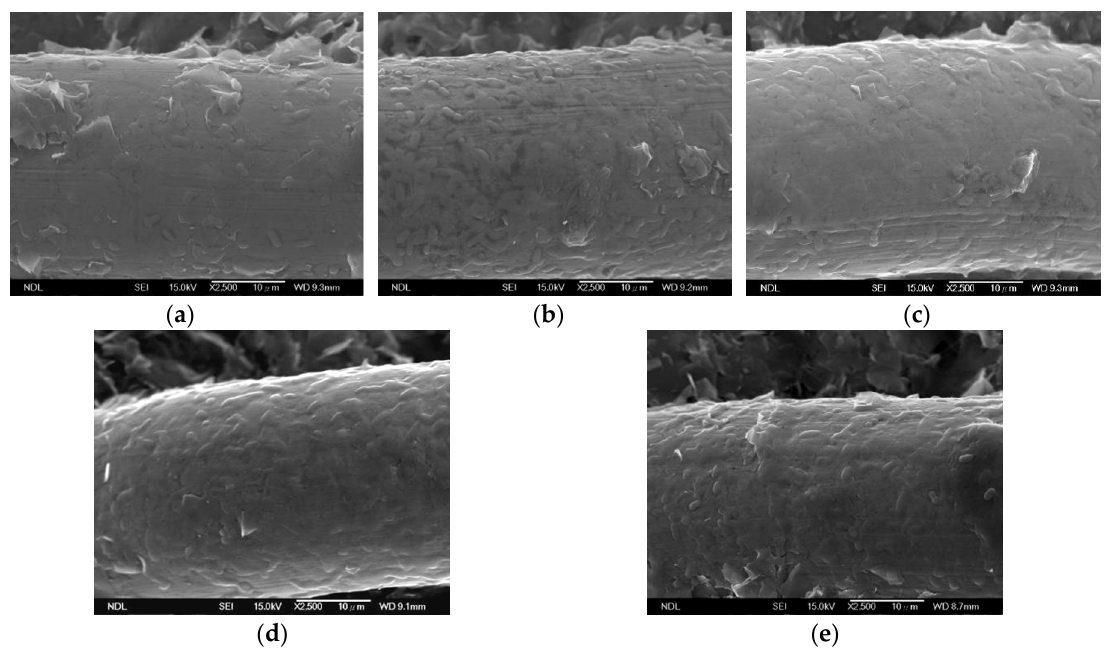
Figure 7. Surface morphology of the anode at ( a ) 1 h, ( b ) 2 h, ( c ) 3 h, ( d ) 5 h, and ( e ) 10 h after the cells were assembled.